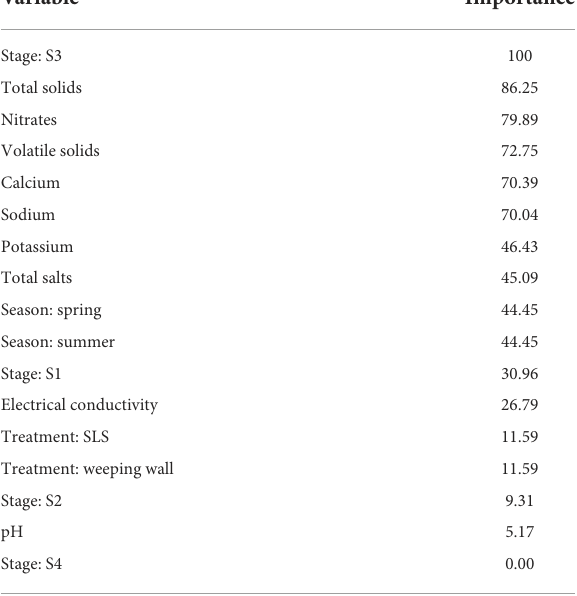
TABLE 2 Variable importance of the regression predictors, scaled to a maximum value of 100, calculated by fitting a non-parametric LOESS R-squared model between the outcome and the prediction